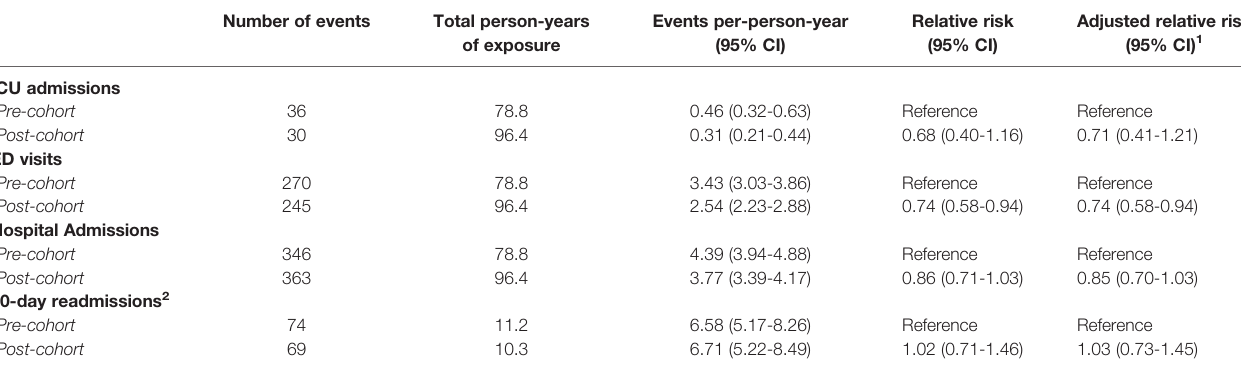
TABLE 2 | Healthcare utilization comparing pre- versus